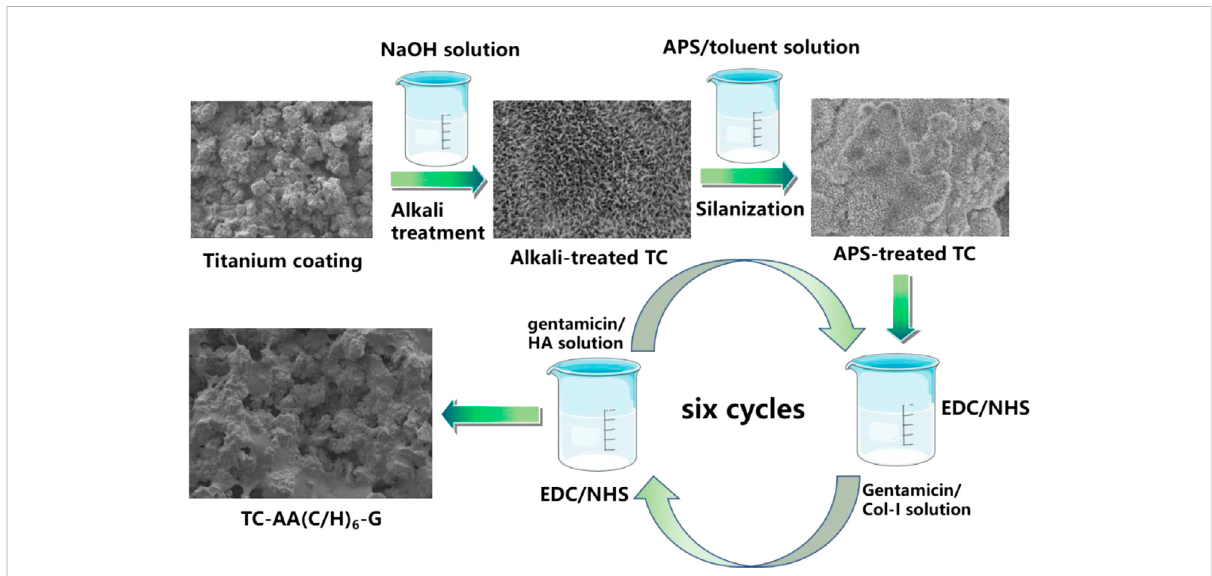
FIGURE 1 Schematic illustration of the fabrication of gentamicin loaded Col-I/HA multilayers on titanium coating via a LBL covalent immobilization